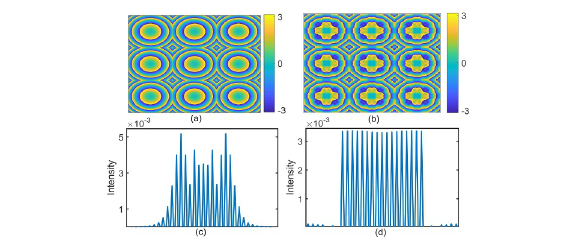
Figure 1. Starting MLA (a), optimized mDOE array phase struc- ture of a 17 × 17 spot array generator (b), intensity distribution of the spot arrays generated by MLA (c) and mDOE array (d).